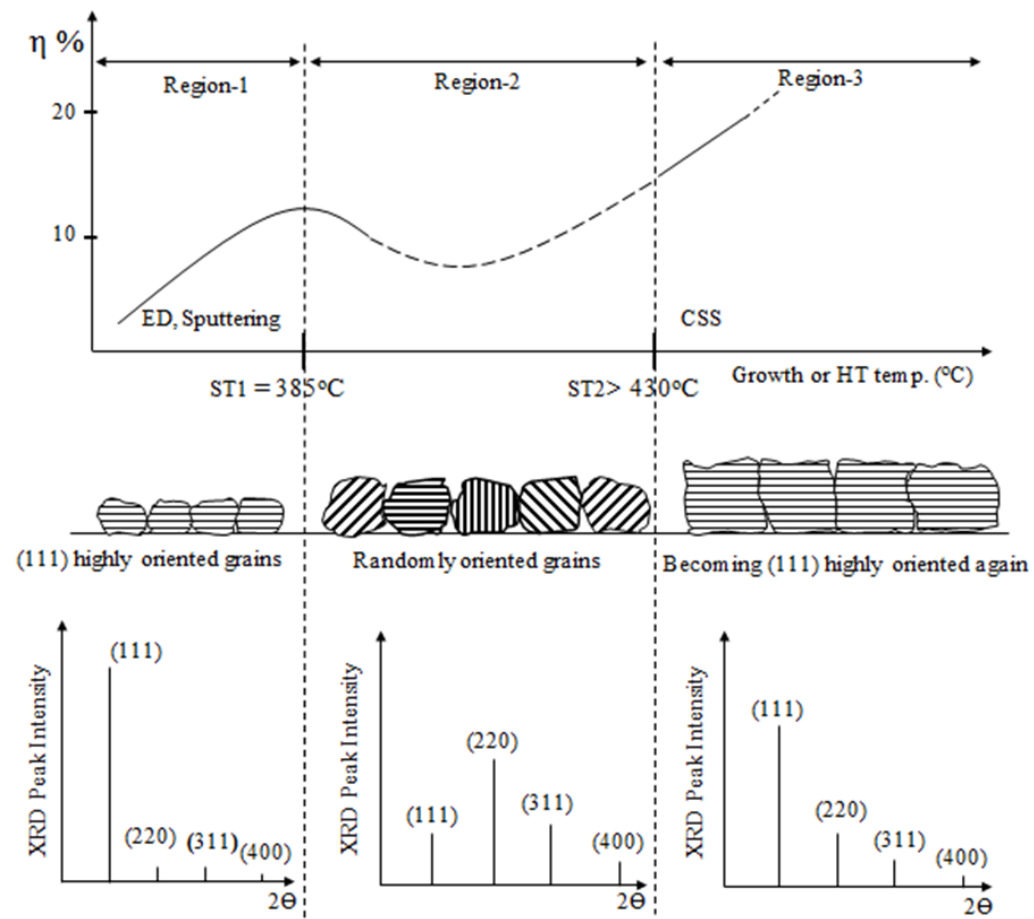
Figure 19. Schematic diagrams summarising CdTe grain growth patterns, corresponding XRD patterns and approximate solar cell efficiencies against growth or heat treatment temperature. Note three regions identified with a sudden phase transition at ST1 = 385 °C, and a slow phase transition taking place after ST2 > 430 °C.